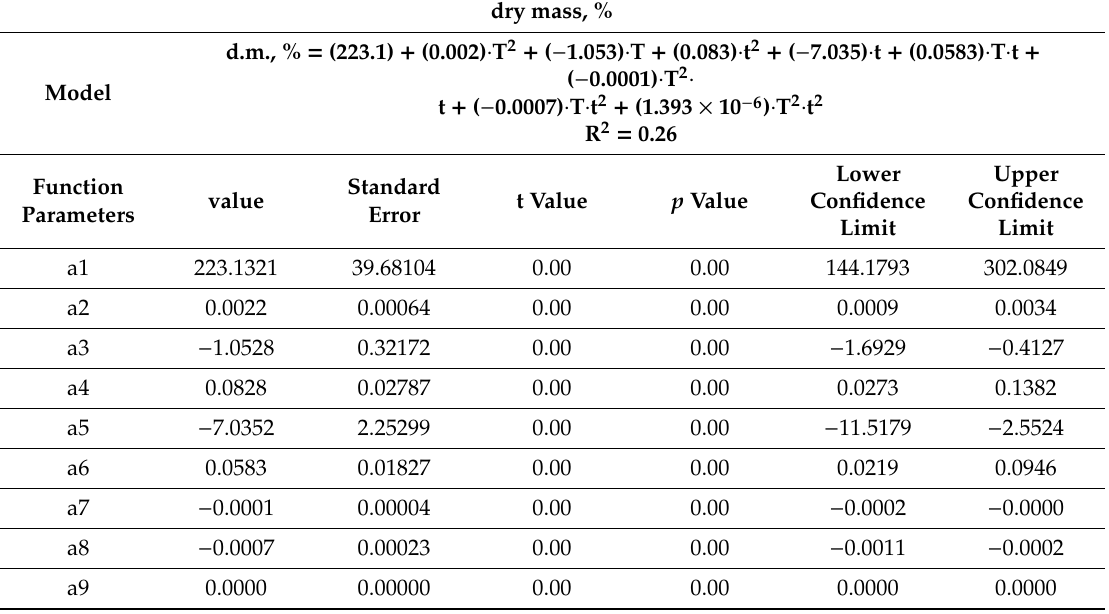
Table A2. The statistical parameters of polynomial regression analysis of the influence of SS torrefaction temperature and residence time on dry mass content in biochars.